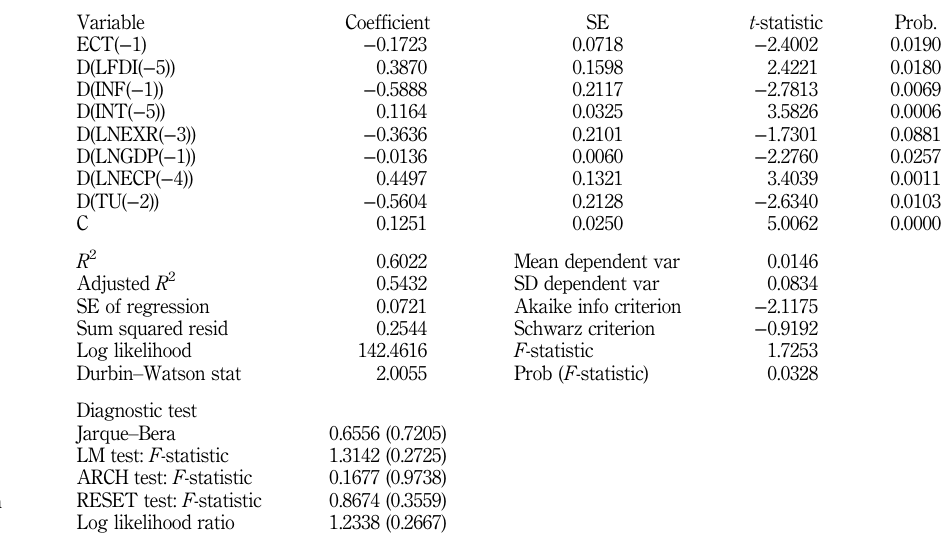
Table VIII. Results of error-correction model